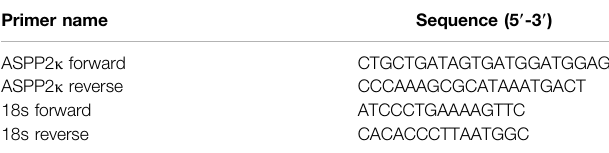
TABLE 1 | Primers used for